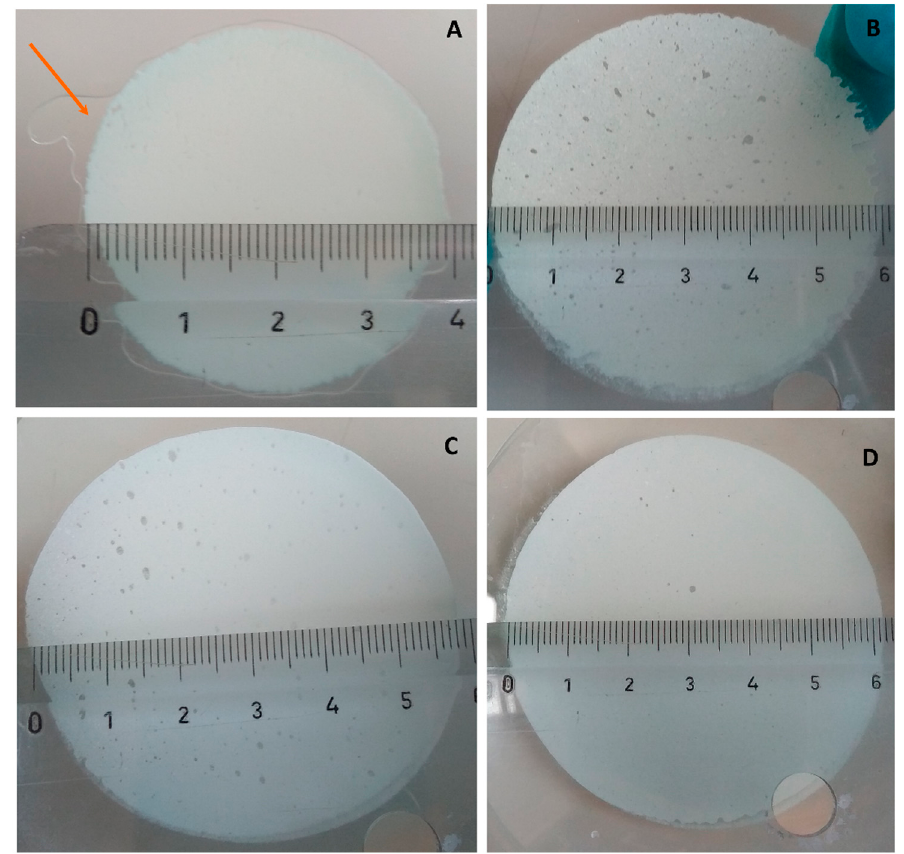
Figure 6. Spread diameter obtained from ( A ) Tiobec ® ; ( B ) ALA-H; ( C ) MgAl-ALA-H and ( D ) ZnAl- Figure6. Spreaddiameterobtainedfrom( A )Tiobec ® ; ( B )ALA-H;( C )MgAl-ALA-Hand( D ALA.